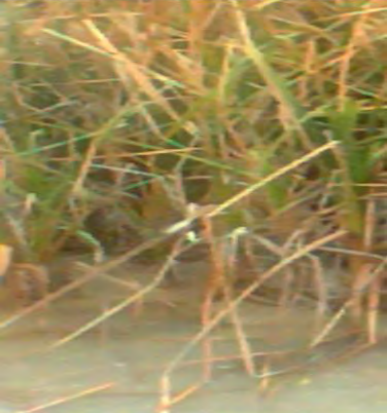
Figure 6. Botomos (locale merged plant )